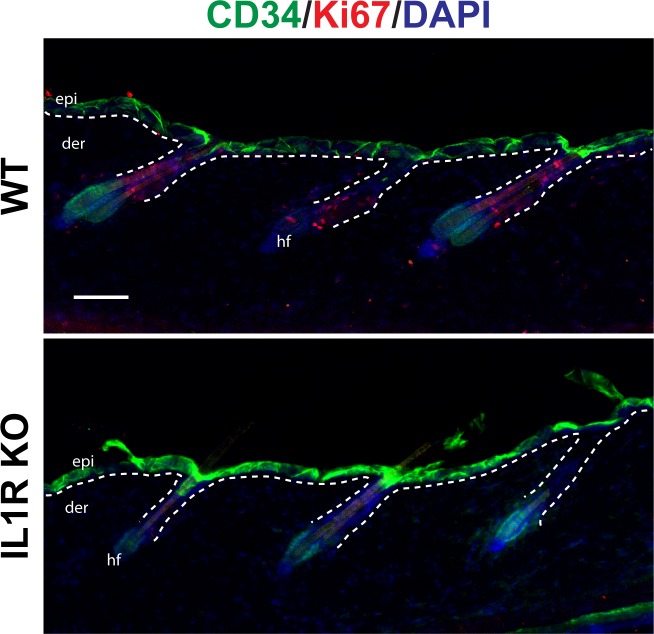
Proliferation of HFSCs in a distal wound region.Immunostaining of day 3 wound distal skin sections from 8-week-old WT or IL-1R KO mice for CD34 (green) and Ki67 (red) to mark proliferating HFSCs. Nuclei were stained with DAPI (blue). Scale bar = 50 µm. The dotted lines represent the epidermal–dermal interface.